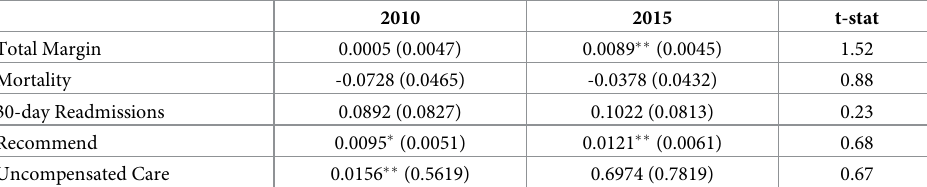
Table 3. Effect of hospital performance measures on CEO compensation by year.